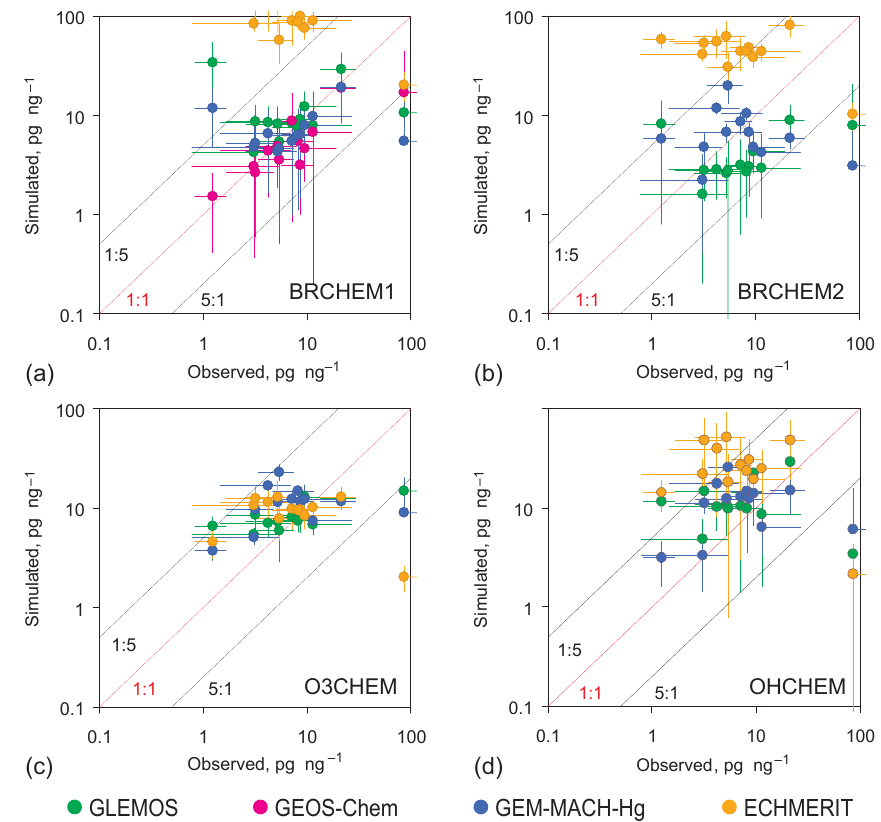
Figure 7. Scatter plots of simulated vs. observed ratios of annual mean RM concentration to GEM concentration in 2013 for different model experiments: (a) BrCHEM1, (b) BrCHEM2, (c) O3CHEM, and (d) OHCHEM. Whiskers show standard deviation of monthly mean simulated and observed values. Dotted red line depicts the 1 : 1 ratio; dotted black lines show deviation by a factor of